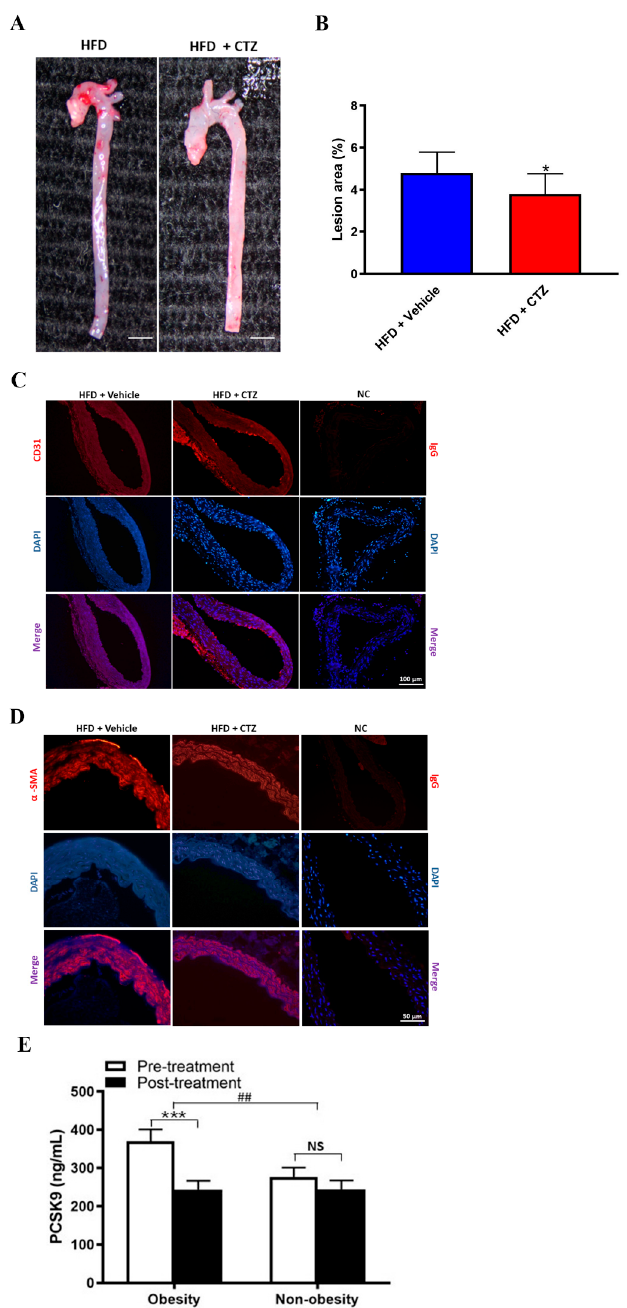
Figure 7. The anti-atherosclerotic effects of cilostazol in HFD-fed mice. ( A , B ) Representative images of aorta specimens from HFD-fed mice treated with vehicle (left) or cilostazol (right), and quantifica- tion of lesion area (%) in HFD-fed mice treated with cilostazol (red bar) and those without (blue bar). * p < 0.05 versus HFD-fed mice treated with vehicle. ( C , D ) Representative images of immunofluo- rescence staining with CD31, α -smooth muscle actin ( α -SMA) (red), DAPI (nucleus, blue), and their colocalization (merge). Scale bar = 100 µ M ( C ) and 50 µ M ( D ). ( E ) Cilostazol treatment significantly reduced serum PCSK9 levels in patients with obesity (369.75 ± 30.94 vs. 243.27 ± 23.36 ng/mL, p < 0.001) but not in those without (276.26 ± 24.57 vs. 243.98 ± 32.14 ng/mL, p = 0.178). The changes in the serum concentrations of PCSK9 post-treatment between obese and non-obese patients were statistically significant ( ∆ PCSK9: 126.48 ± 24.93 vs. 32.28 ± 23.68 ng/mL, p = 0.009). *** p < 0.001 and NS: not significant ( p > 0.05), comparison between groups. ## p < 0.01, comparison between obesity and